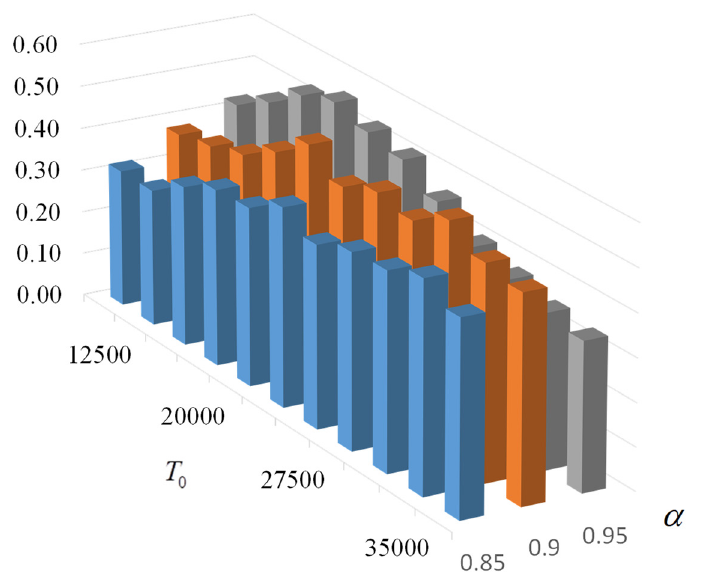
α= k = 650 (each 0.85; 0.9; 0.95 and int